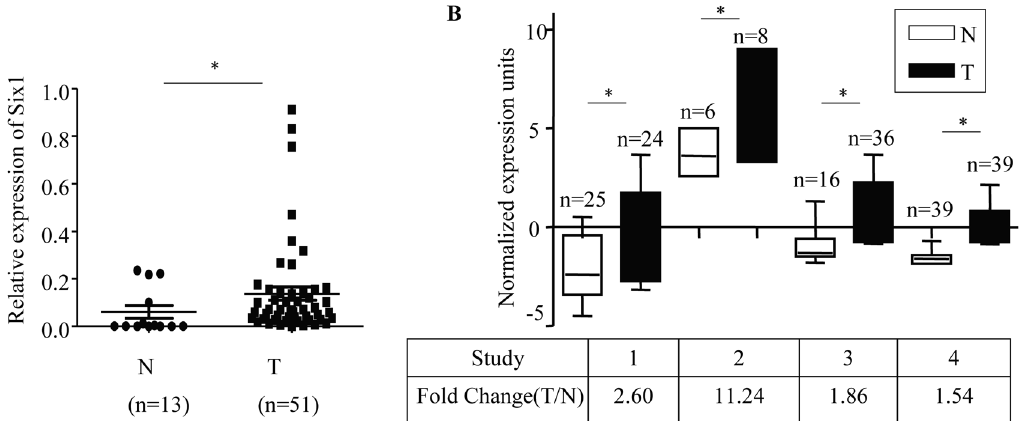
Figure 1. Expression of Six1 in pancreatic cancer. (A) The relative mRNA expression level of Six1 was determined by quantitative Real-time RT- PCR in 51 pancreatic ductal adenocarcinomas and 13 adjacent non-tumor pancreatic tissue samples. Results were normalized to the expression level of GAPDH mRNA in each sample. * P , 0.05. (B) ONCOMINE database was used to analyze previously published microarray data. Levels of Six1 mRNA are increased in pancreatic cancer when compared with adjacent non-tumor pancreatic tissue. All results, including p -values, were calculated using ONCOMINE data. N, adjacent non-tumor pancreatic tissue; T, pancreatic ductal adenocarcinomas; * P , 0.05.